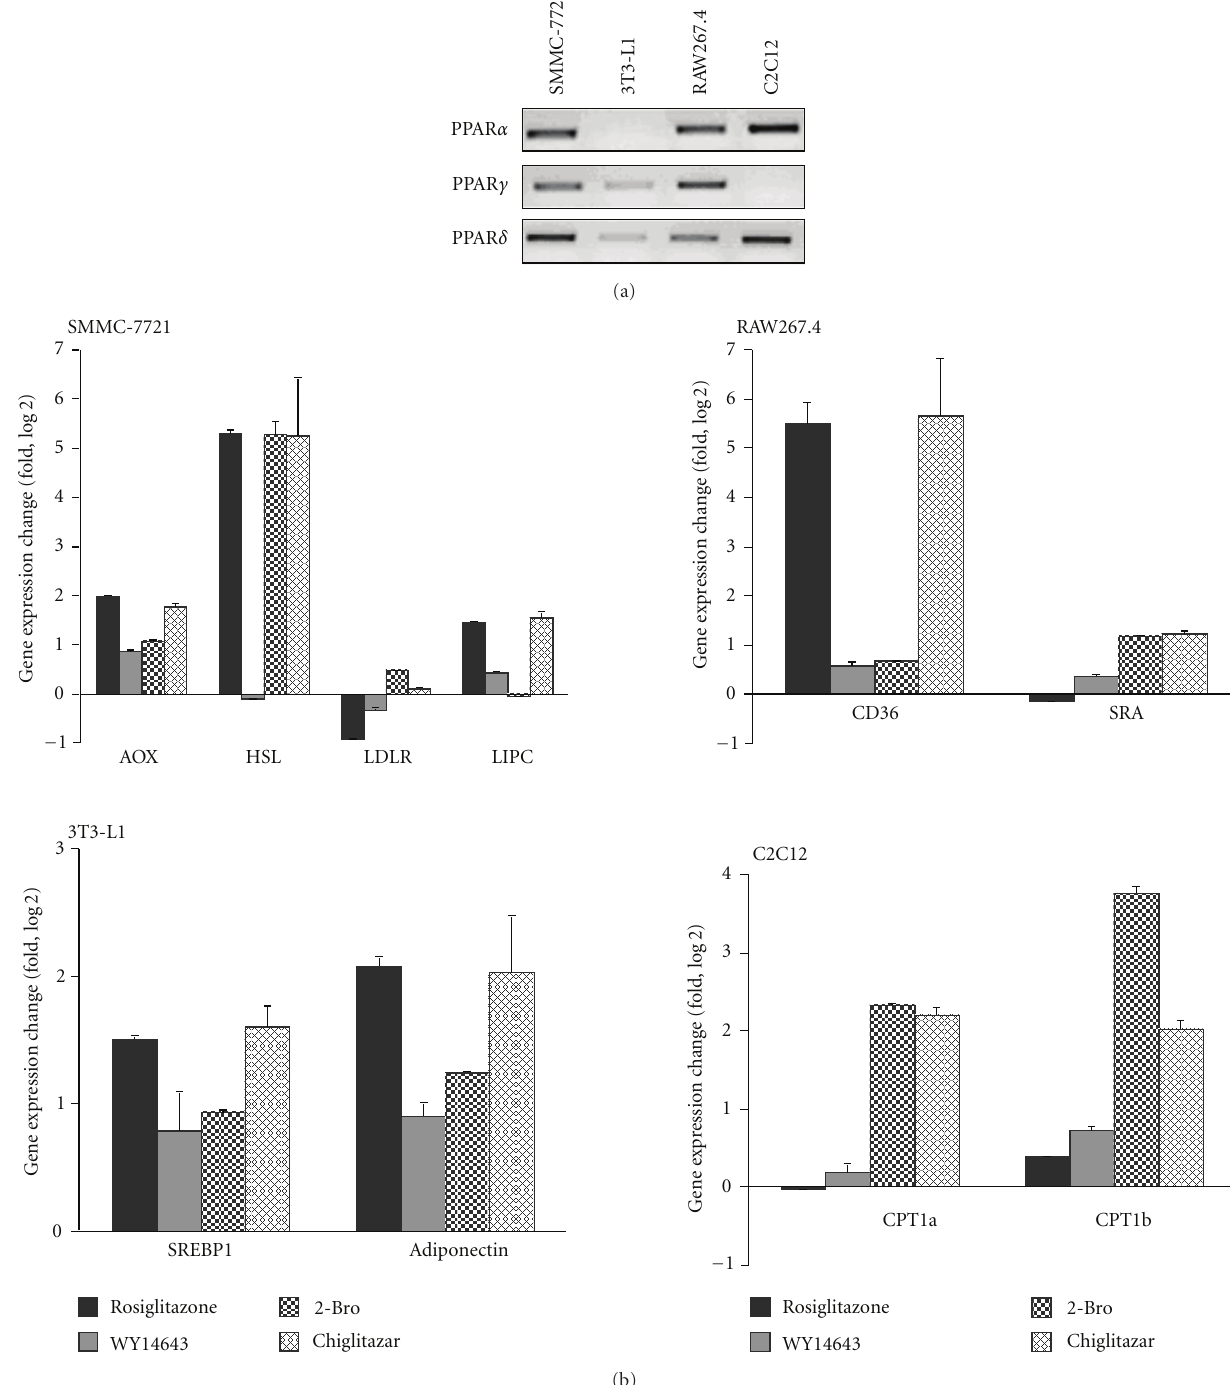
Figure 1: In vitro regulation of gene expression by chiglitazar. (a) Endogenous expression of individual PPAR subtypes in cell lines. (b) The indicated cell lines were treated with 10 μ M rosiglitazone, 50 μ M WY14643, 5 μ M 2-bromohexadecanoic acid (2-Bro), 10 μ M chiglitazar, or vehicle control (0.1% DMSO), respectively, for 48h. Total RNA was isolated and RT-PCR was carried out using primers of the individual genes as listed in Table 1. The expression change of referred genes induced by di ff erent compounds was normalized against internal control (36B4 or GAPDH) and then compared with vehicle control treatment. The data shown are averaged from 3 independent